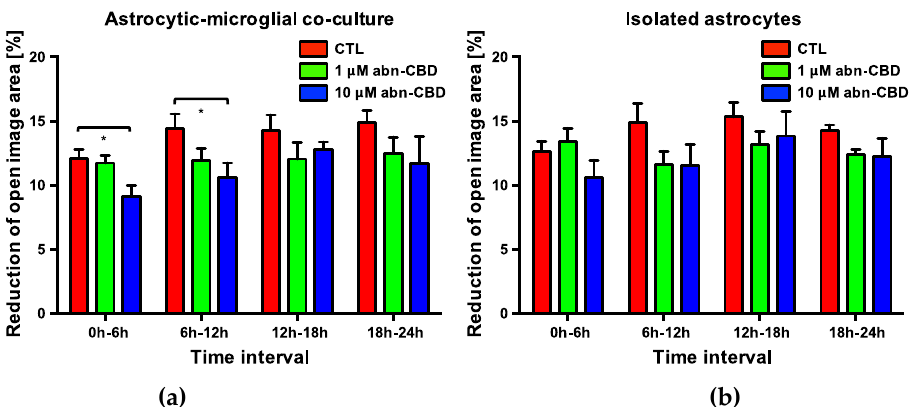
Figure 6. Reduction of open image area in astrocytic-microglial cocultures ( a ) and isolated astrocytes ( b ). Data is expressed as mean ± SEM, n = 8 in each group. Statistical analysis was done using one-way ANOVA followed by Bonferroni’s post-test. * p < 0.05.